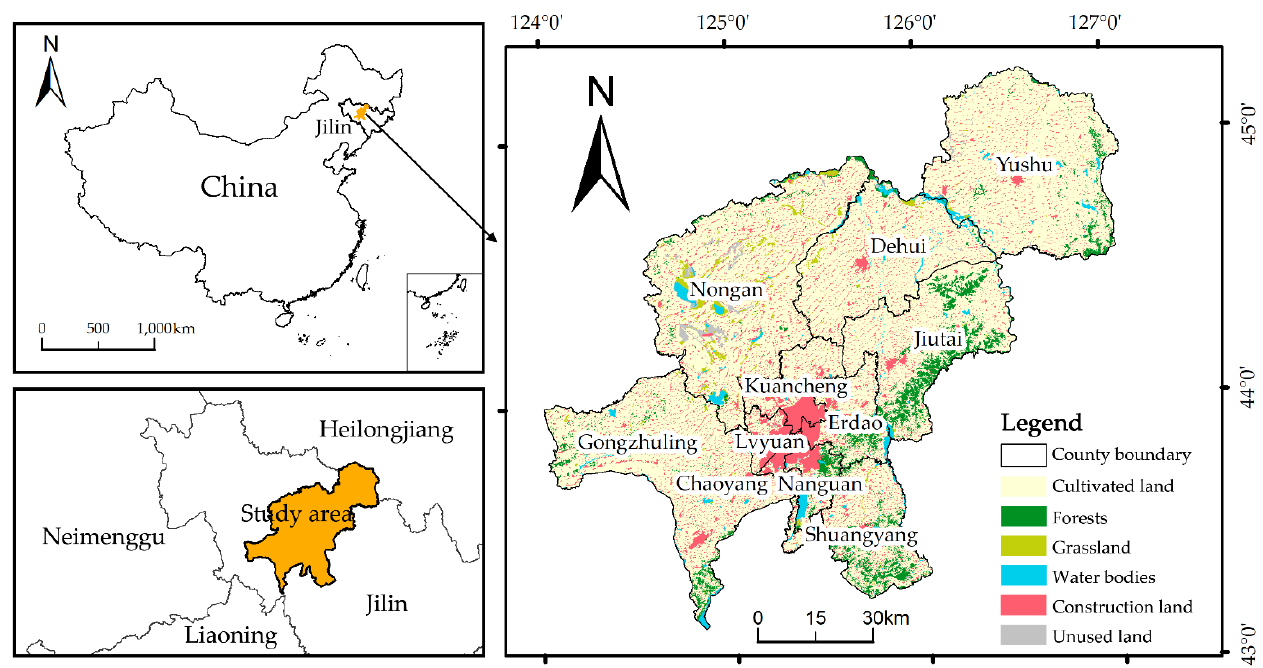
Figure 1. Location and land use types of the study area.